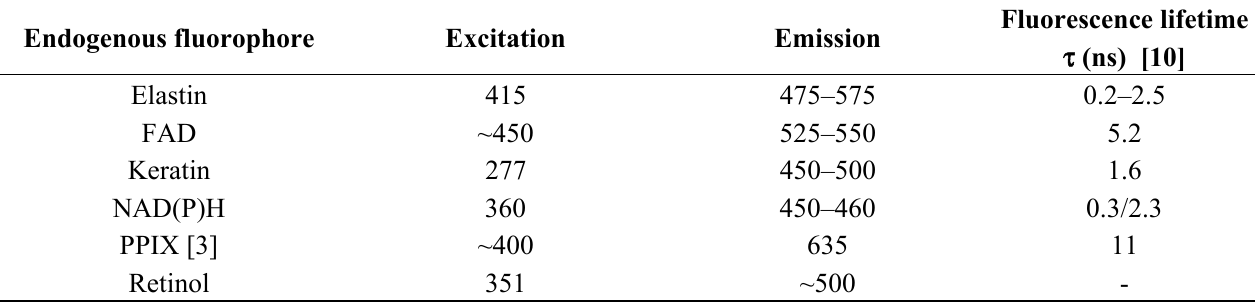
Table 1. Fluorescence properties of endogenous